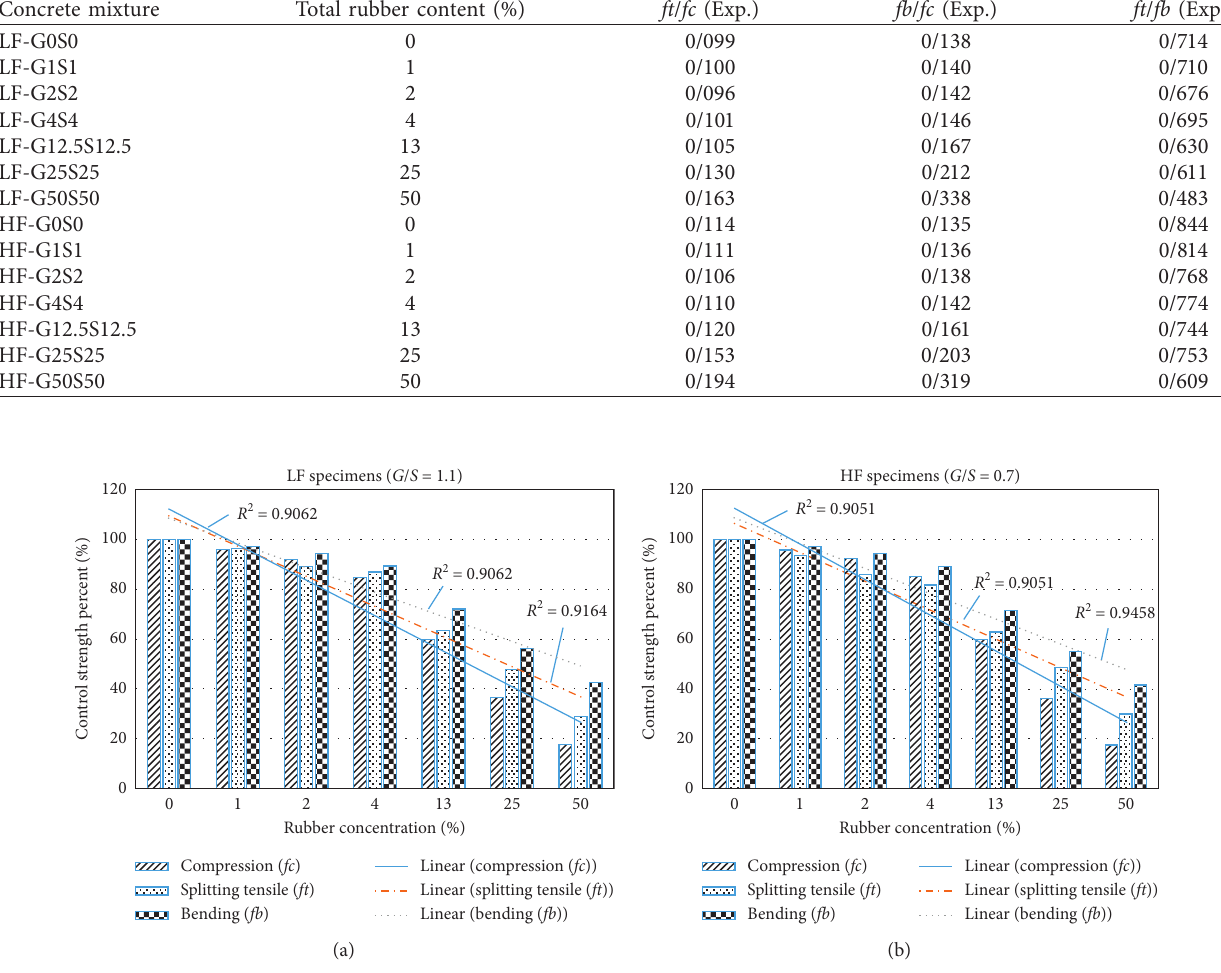
Figure 6: Variation of strengths with respect to control strength in different silicone rubber content. (a) LF specimens. (b) HF specimens.